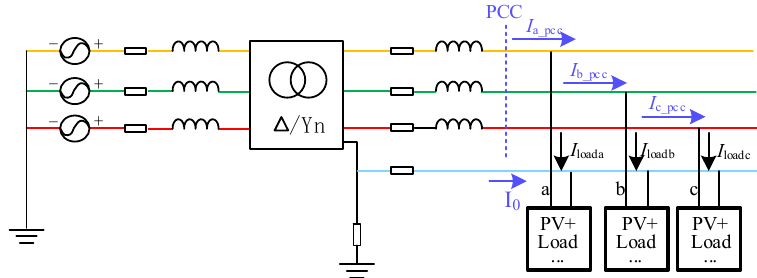
Figure 1. Three-phase four-wire distribution system.